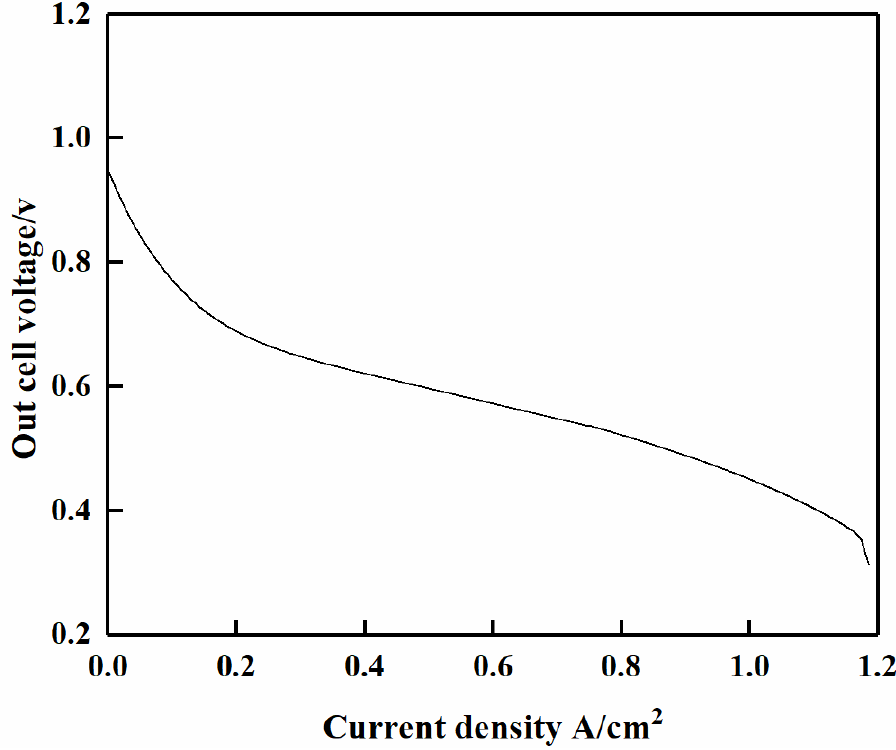
Figure 3. The polarization curve of the fuel cell model.